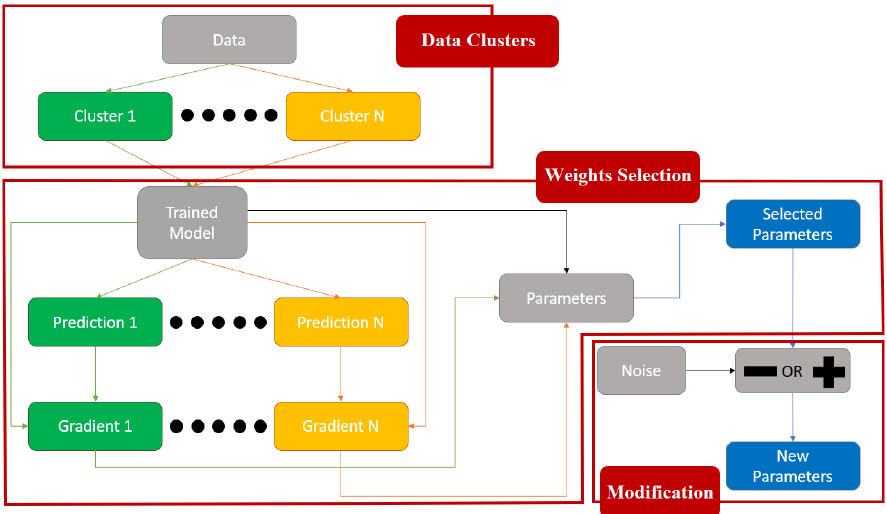
Figure 2. The process followed by the attack we developed and implemented in this